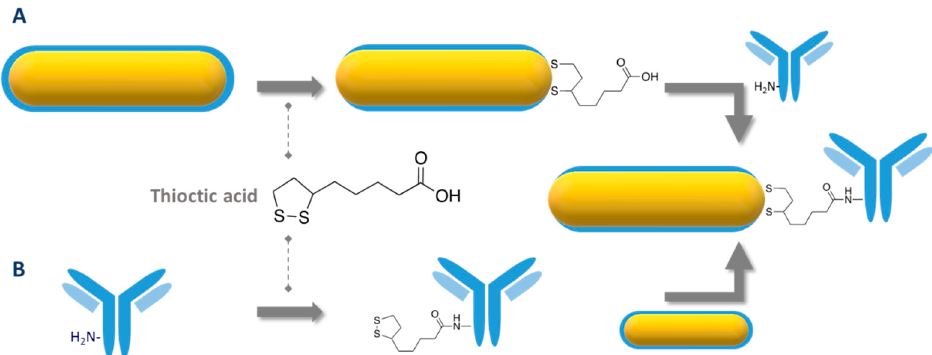
Figure 20. Tip-selective covalent conjugation bioreceptor to CTAB-capped AuNR. ( A ) Grafting of thioctic acid to AuNR followed by conjugation via N-(3-Dimethylaminopropyl)-N ′ -ethylcarbodiimide (EDC)/N-Hydroxysuccinimide (NHS); ( B ) coupling of thioctic acid to antibody via EDC/NHS followed by grafting to AuNR.